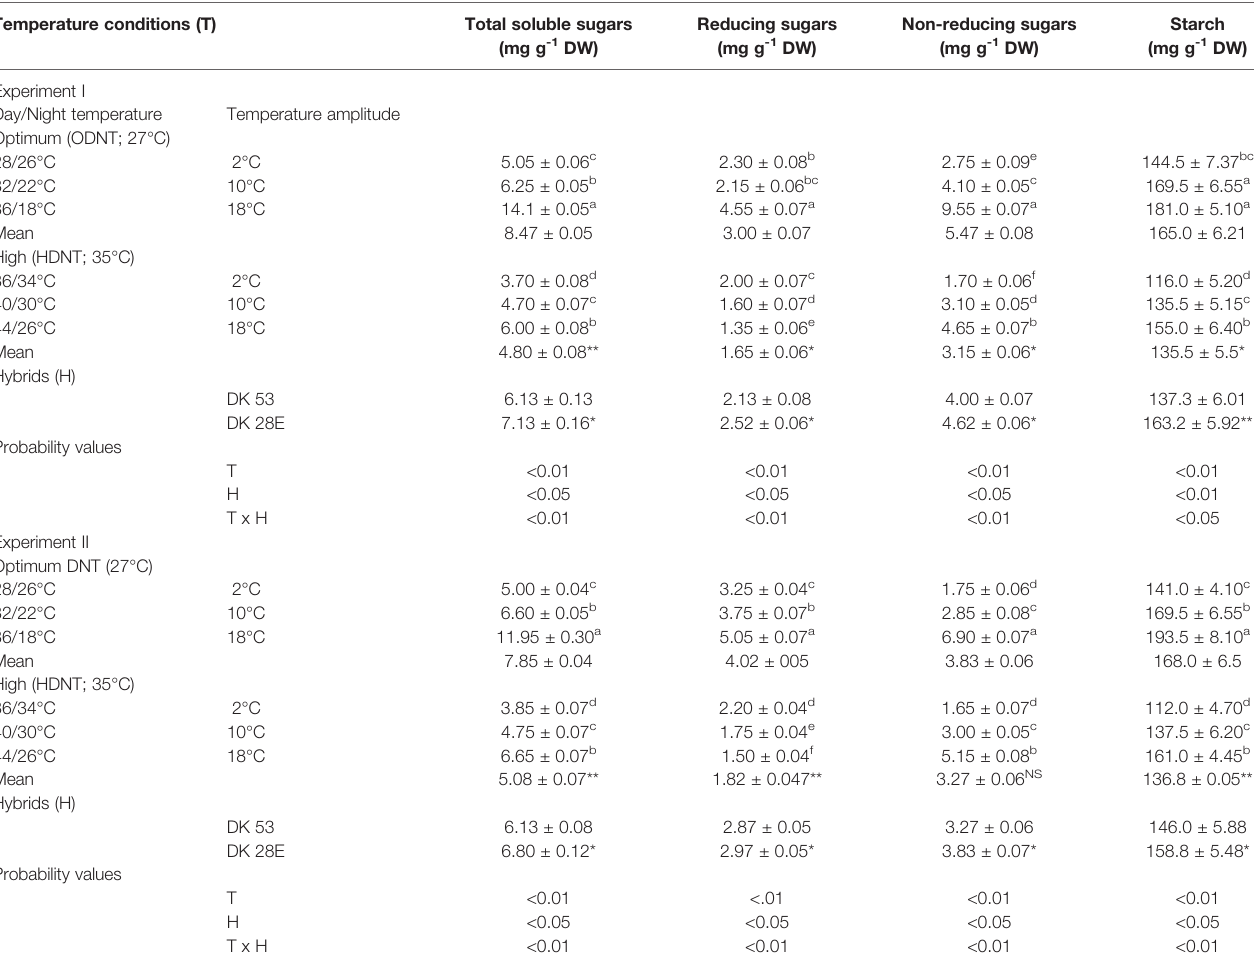
TABLE 2 | Effect of two mean temperatures [27°C (optimum mean daytime and nighttime temperature; ODNT) and 35°C (high mean daytime and nighttime temperature; HDNT)] with three diurnal temperature amplitudes (2, 10, and 18°C) on carbohydrate composition in sorghum hybrids (DK 53 and DK 28E). Temperature conditions